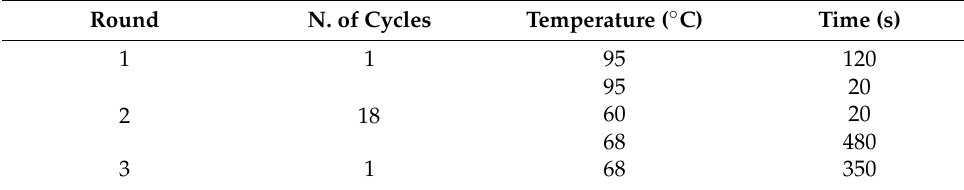
Table 1. Specifications for the PCR